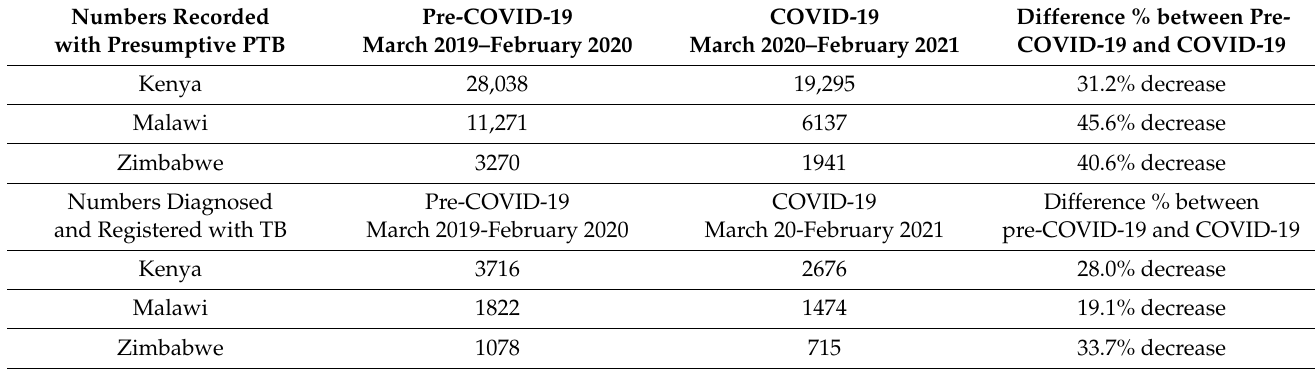
Table 4. Numbers with presumptive PTB and registered TB in the pre-COVID-19 and COVID-19 periods in Kenya, Malawi and